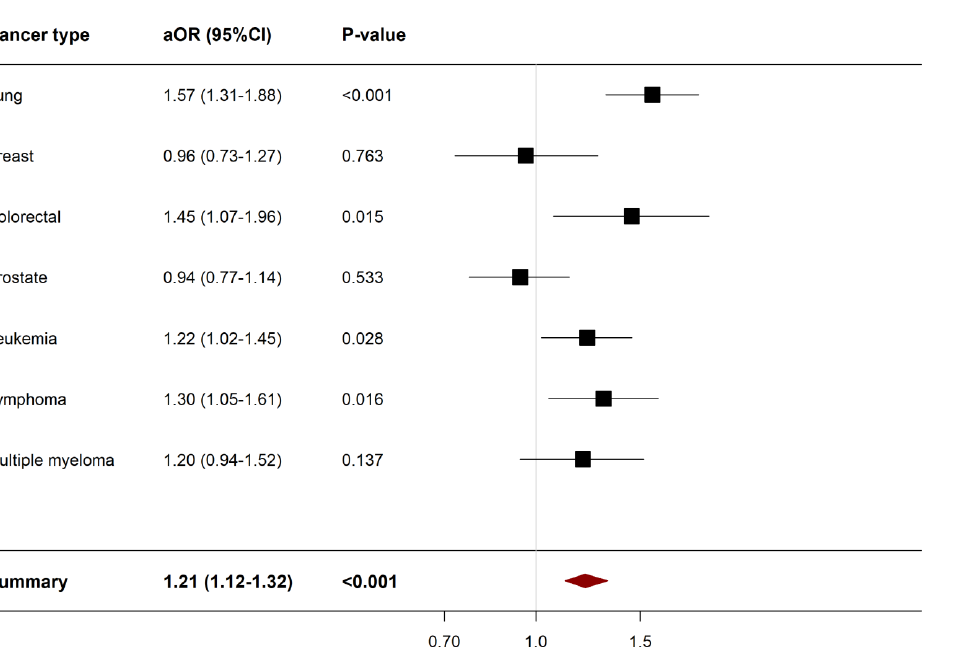
Figure 2. Forest plot describing the results of sensitivity analysis of all-cause in-hospital mortality according to cancer type. Abbreviations: aOR; adjusted odds ratio, CI, confidence interval, Variables were adjusted for were age, sex, race, admission type, admission day, hospital bed size, hospital teaching status, hospital region, insurance status, median annual income, and comorbidities. Statis- tical significance ( p -value < 0.05).